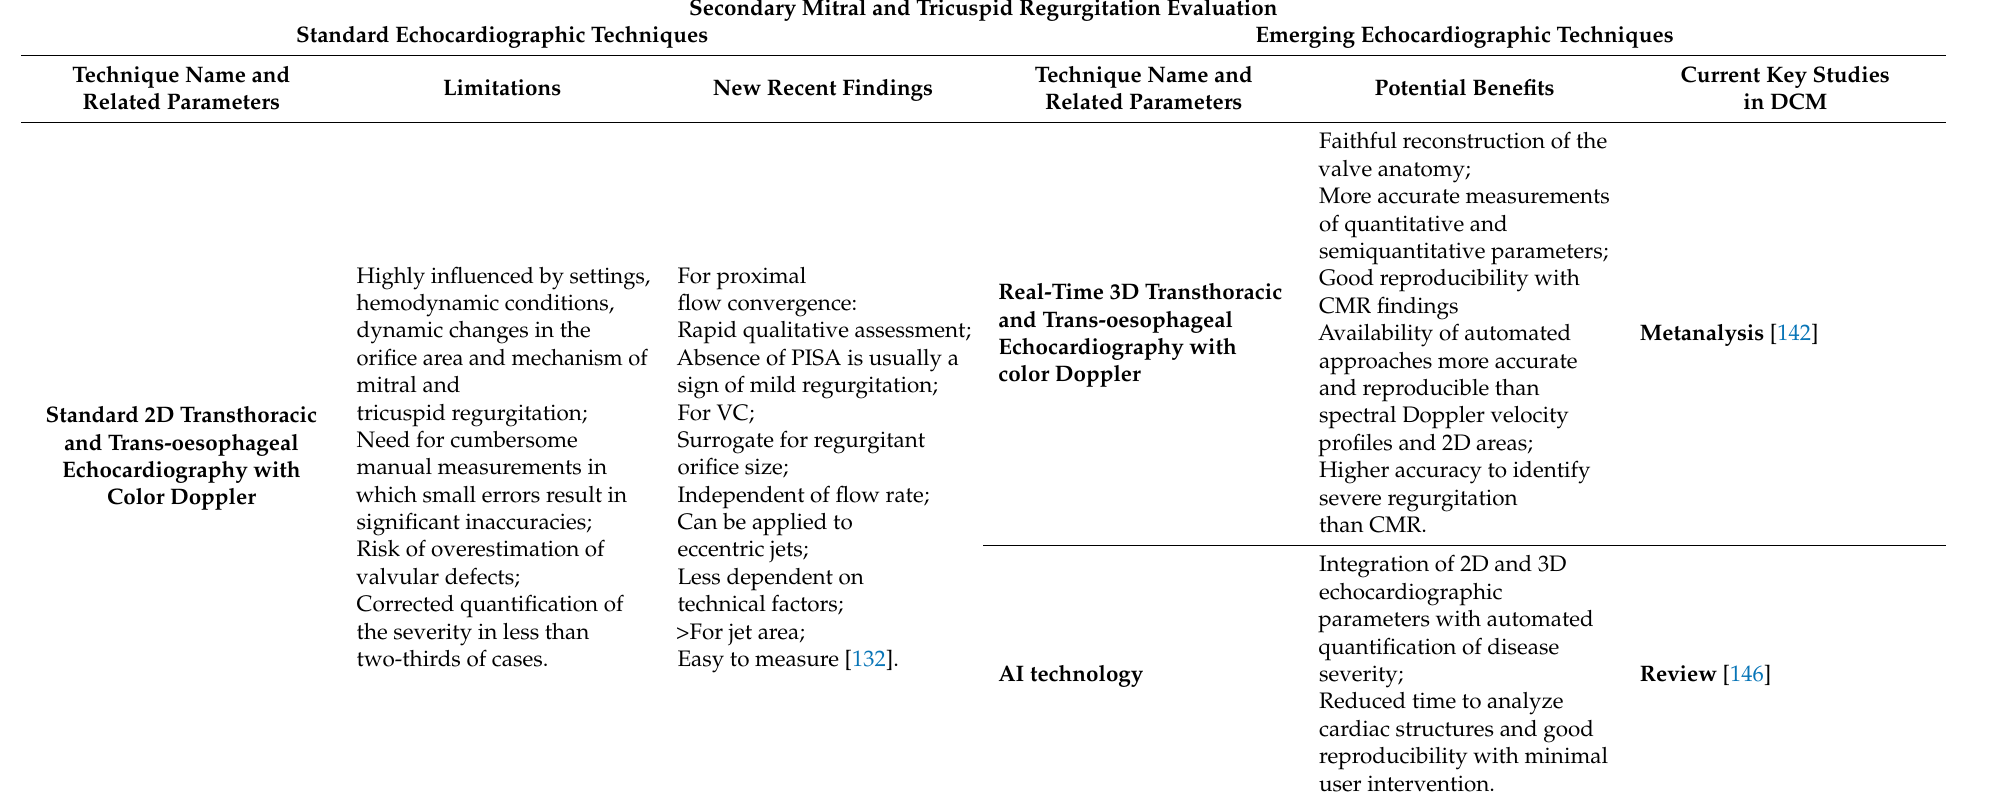
Table 5. Comparison between Standard and Emerging echocardiographic techniques to evaluate mitrale and tricuspid regurgitation in dilated